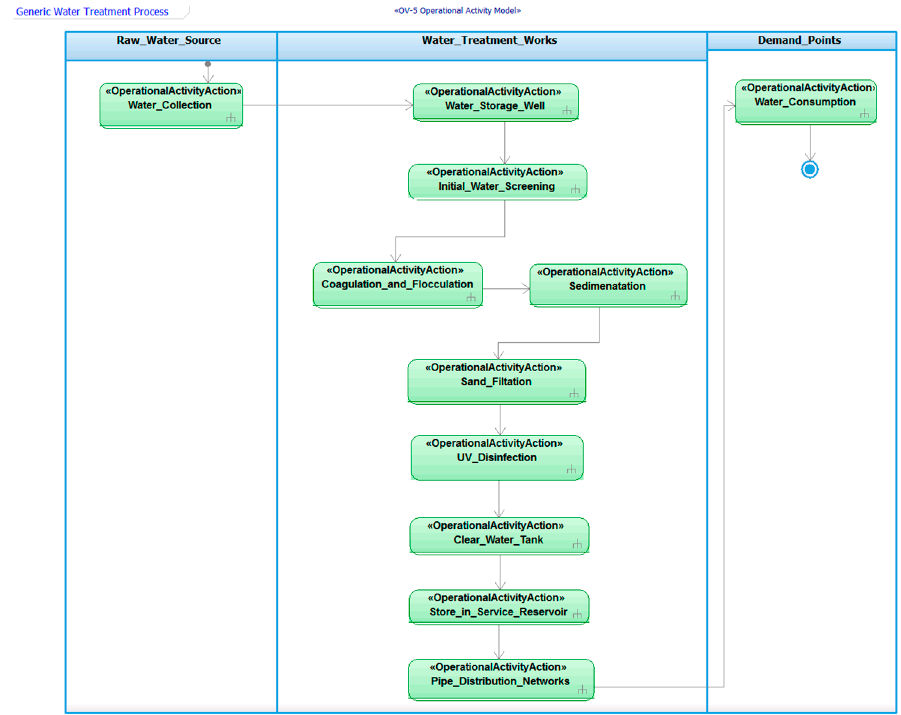
Figure 8. OV-5b—Operational view of high-level water treatment process .